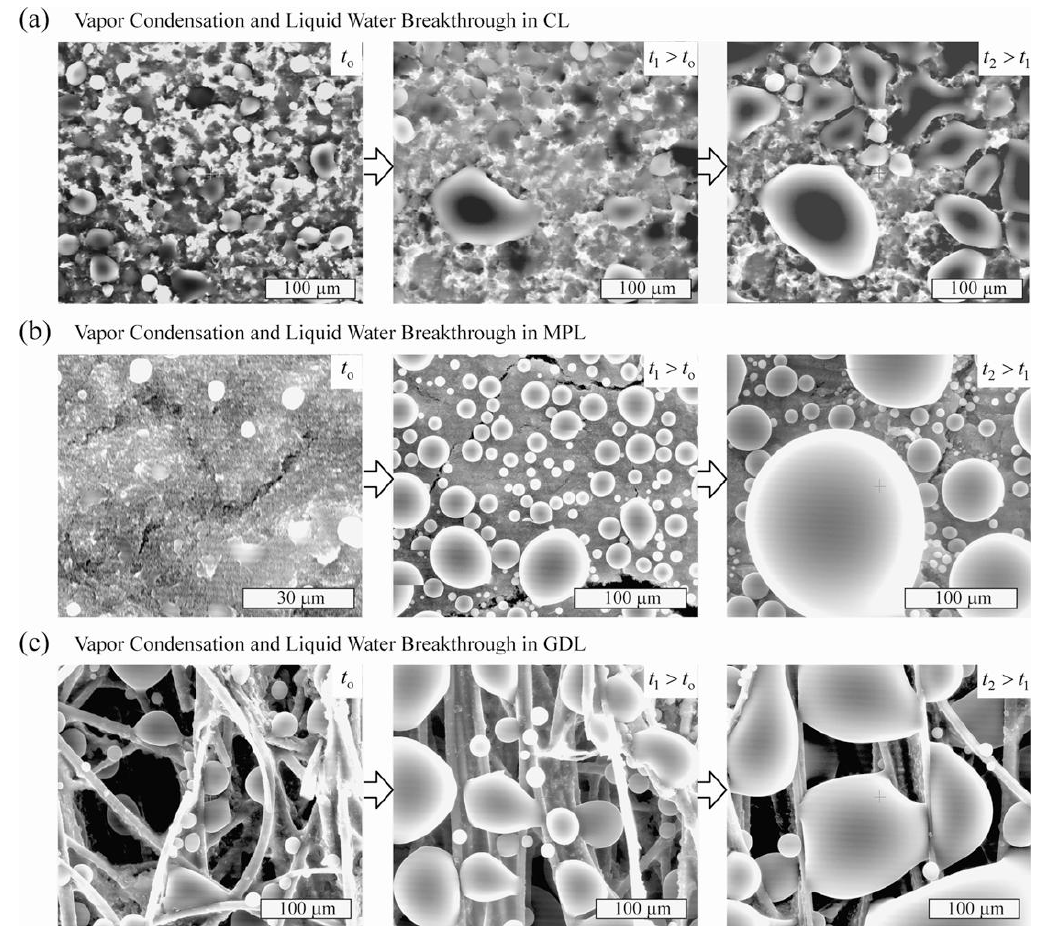
Figure 7. ESEM micrographs showing vapor condensation and liquid water breakthrough from (a) CL, (b) MPL, and (c) GDL. For each, micrographs at three different elapsed times are shown